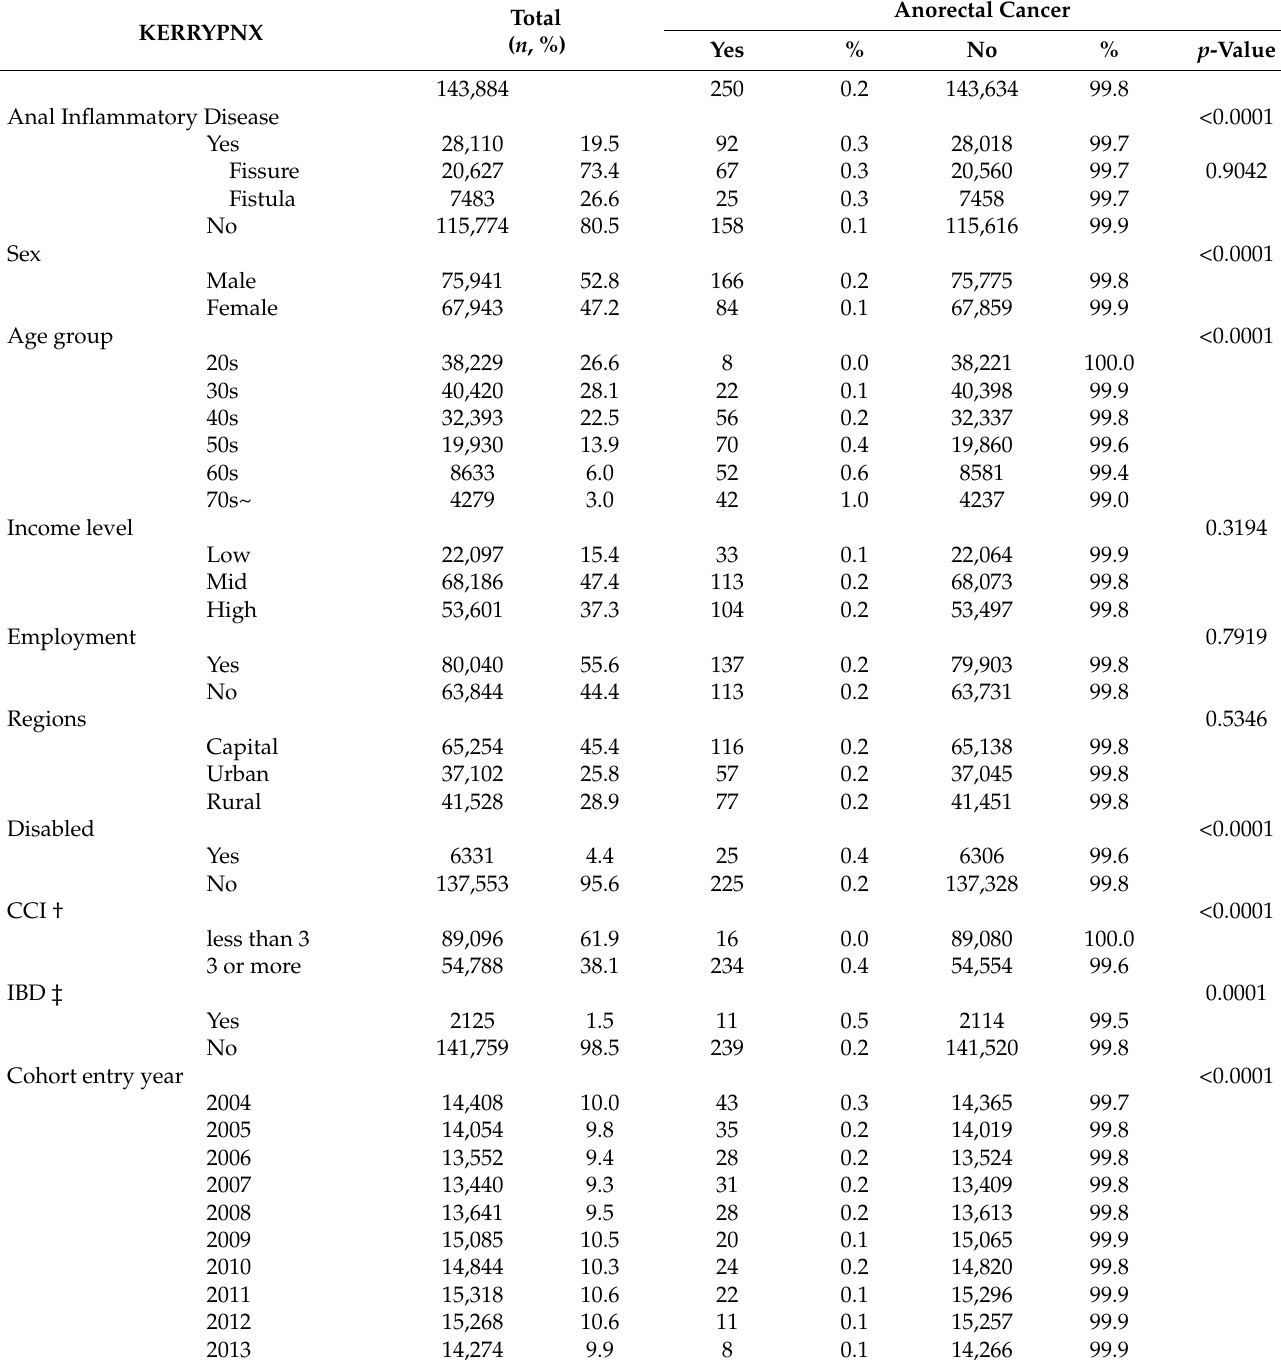
Table 1. General characteristics of the study